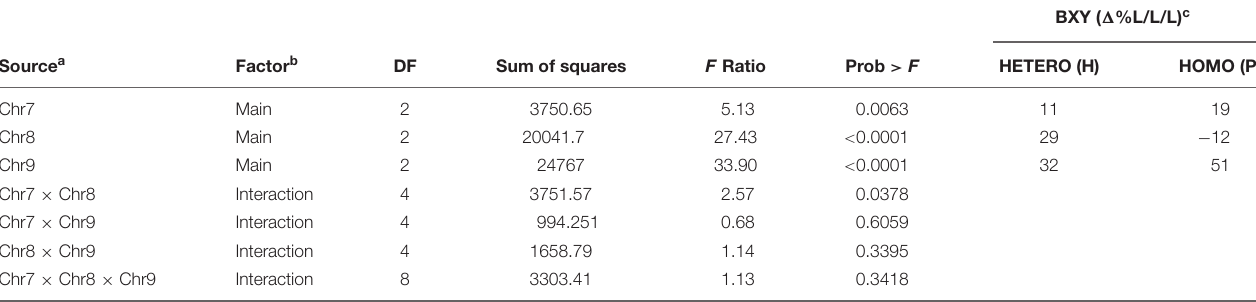
FIGURE 5 | 3D genotype and BXY of the IL789 pyramid. Each node represents a genotype from the 27 (3 ∧ 3 ) combinations. The different axes represent the different introgressions on chromosome 7, 8, and 9. L = homozygote lycopersicum , H = Heterozygote, P = homozygote pennellii . Colors reflect the mean BXY values for each genotype as calculated from 20 replicates of single plants. The green dashed line highlights single QTL effects. TABLE 3 | 3-way Analysis of Variance (ANOVA) of BXY for the ‘immortalized F2’ from the IL789